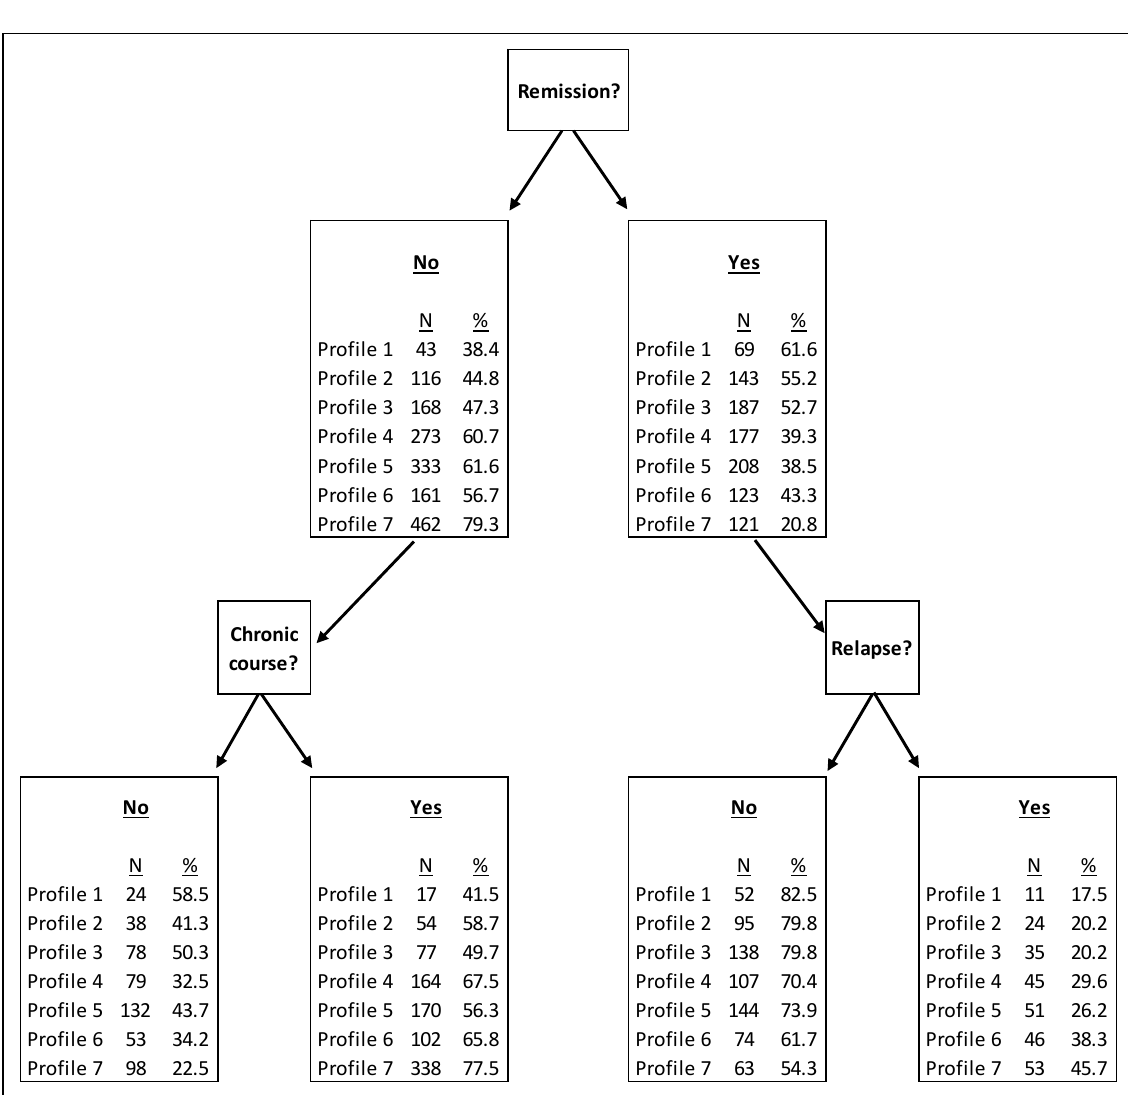
Figure 1. Outcomes between profiles.